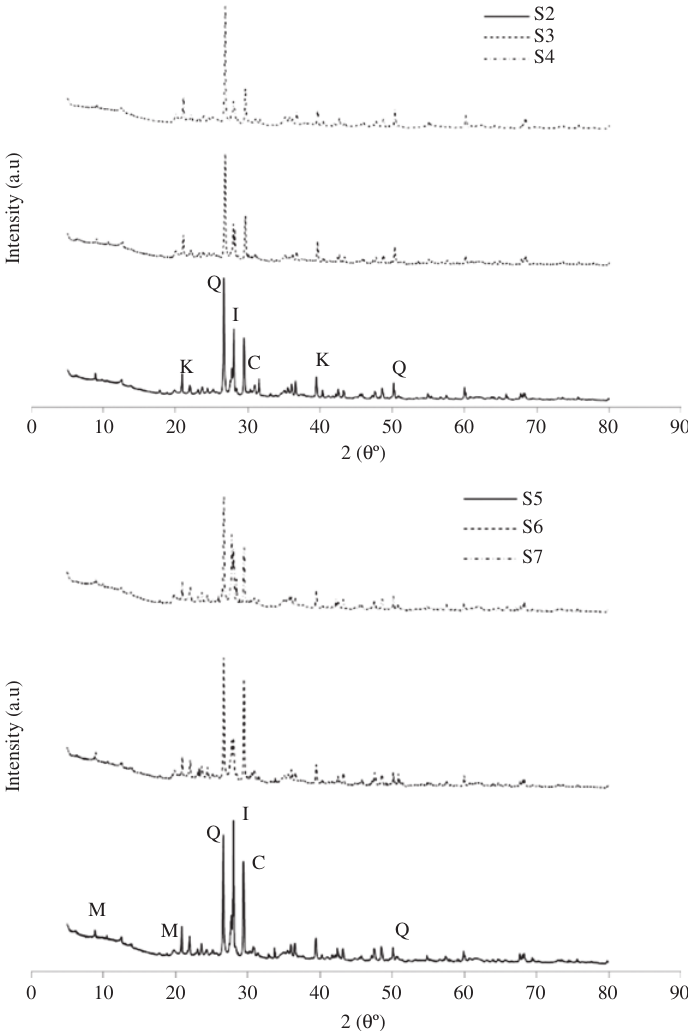
Figure 2 X-ray diffraction patterns of artifically mixed soil samples. K, Kaolinite; I, illite; Q, quartz; C, calcite; I, illite; Q, quartz; C, calcite; M, montmorillonite.